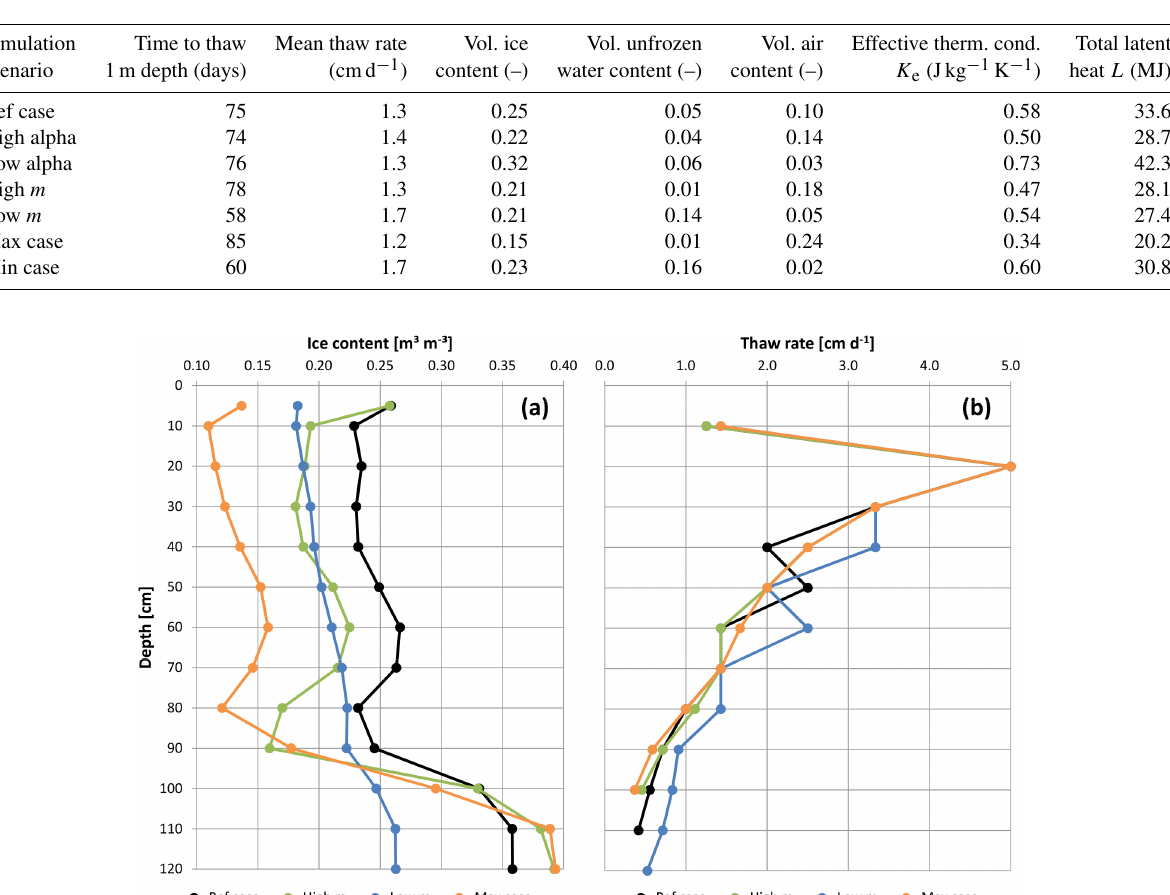
Table 7. Simulated thaw progression to 1m depth including the water phase state after the onset of positive ground surface temperatures in May 2011.